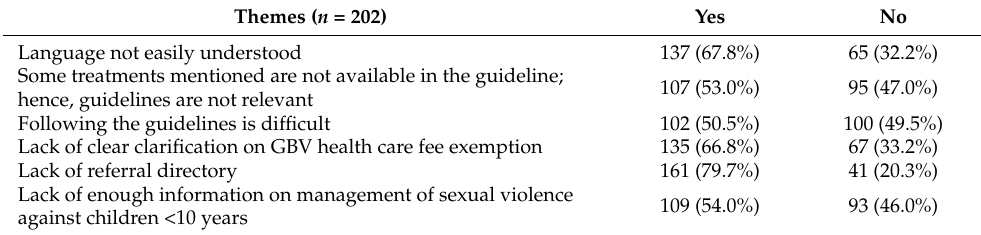
Table 5. Gaps of gender-based violence (GBV) management